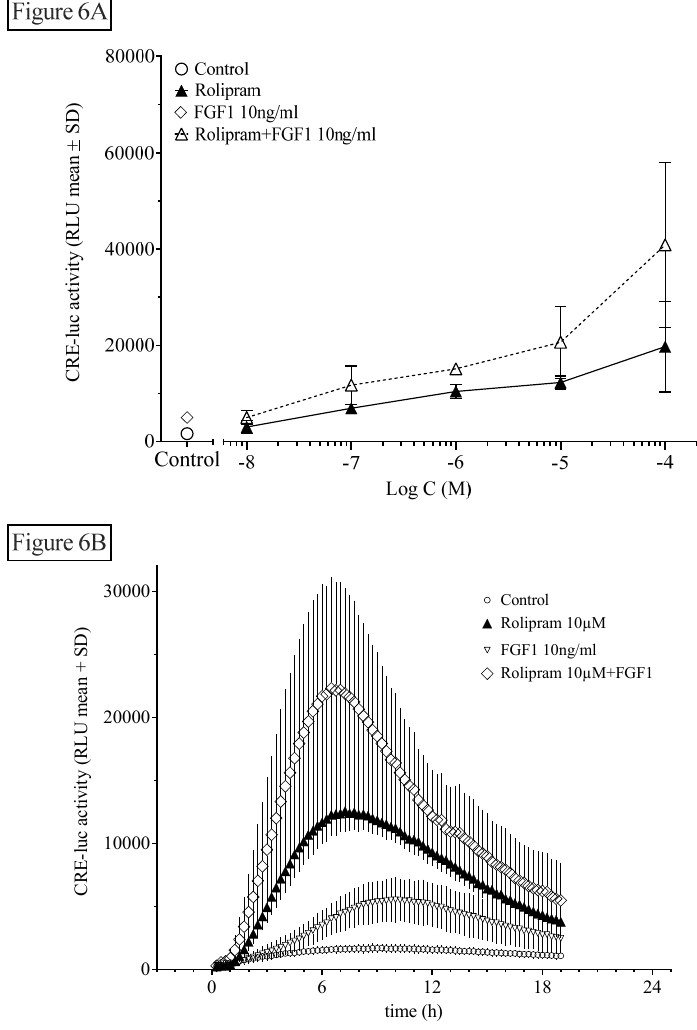
Figure 6. Fibroblast growth factor 1 (FGF1) application further elevates rolipram-induced HT22CREluc activity. ( A ) HT22CREluc activity, elevated by the PDE4-selective inhibitor rolipram, was further enhanced by co-application of FGF1 (10 ng / mL). Mean values with standard error (mean ± SD) of four repetitions ( N = 4) are shown. ( B) Time-resolved curve with FGF1 (10 ng / mL), rolipram (10 µ M), and the combination of both in comparison to control (untreated) levels (mean ± SD; N = 4). Note the later onset and maximum of HT22CREluc activity induced by FGF1 (~9 h) in comparison to rolipram (~7 h). All data are from the Centro luminometer.